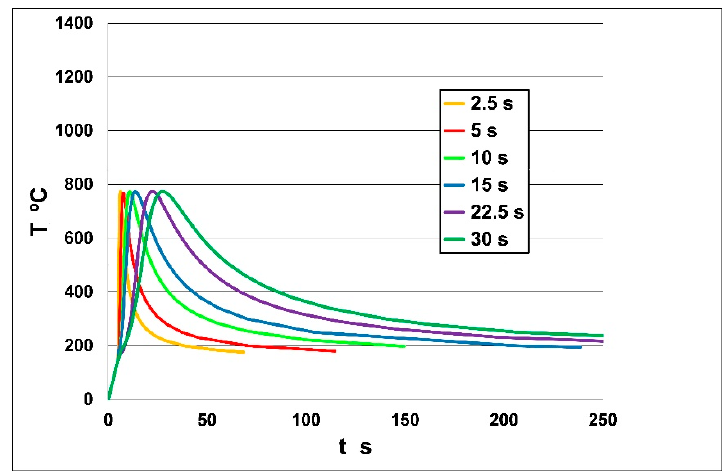
Figure 1. Coarse-grained heat-affected zone (CGHAZ) thermal cycles.